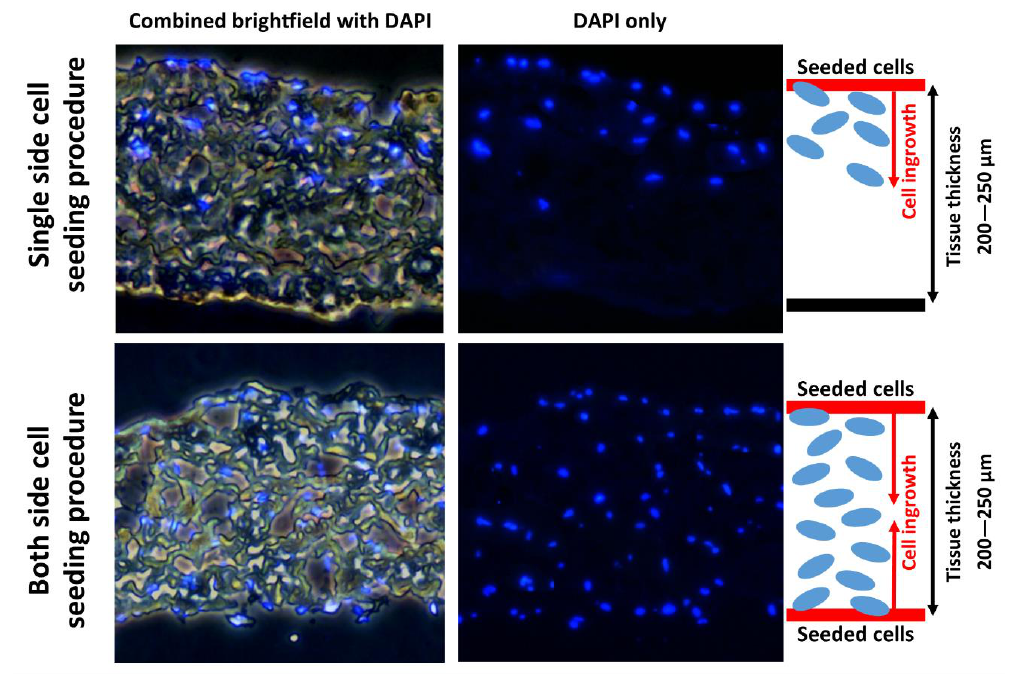
Figure 10. Comparison between single- and both-sides cell seeding procedures. The cultivation time in both procedures was 5 days in dynamic conditions.